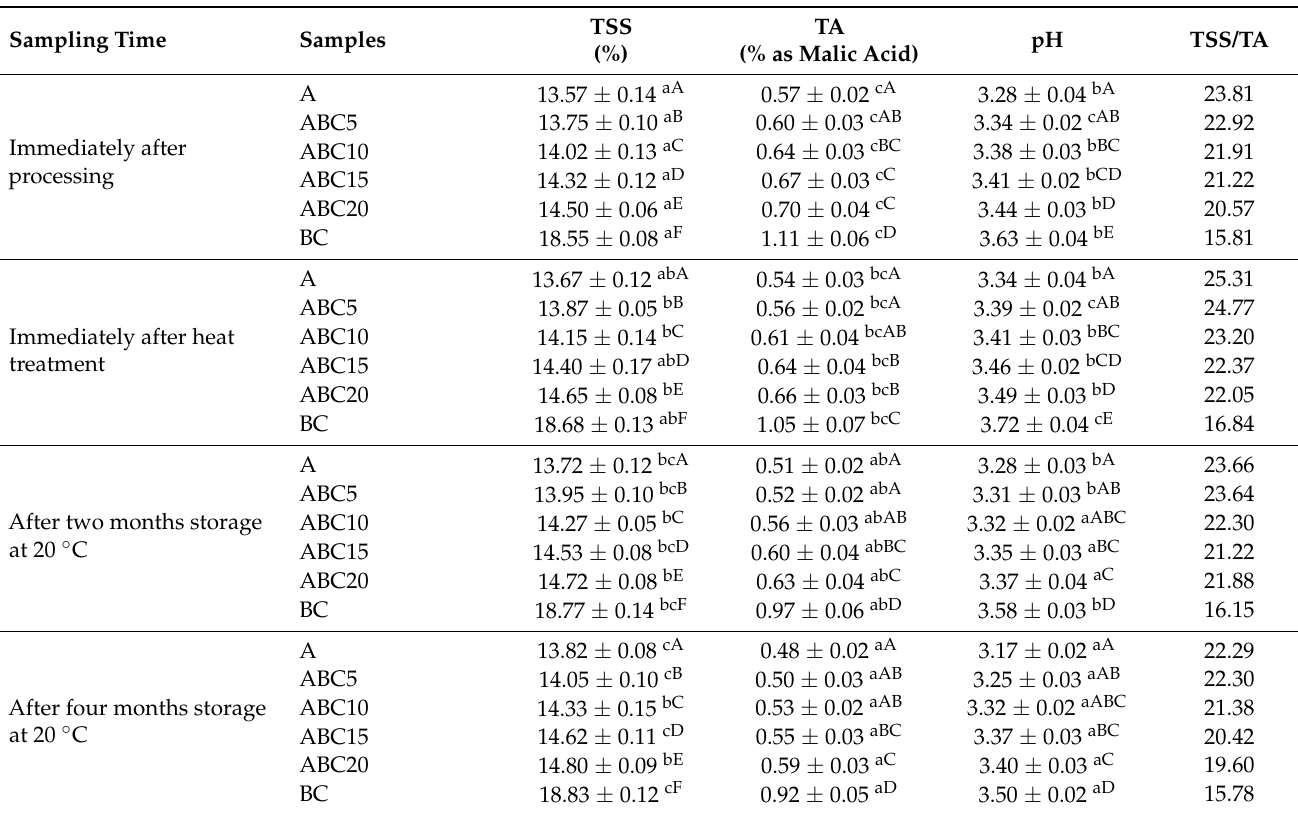
Table 1. Physicochemical parameters of the tested juices immediately after processing, after the heat treatment, and after four months of storage